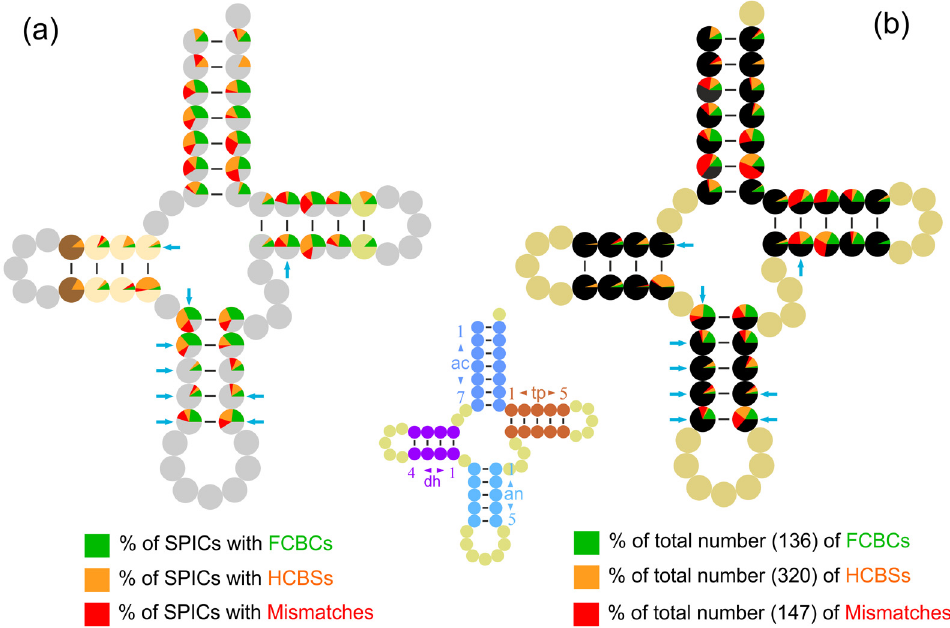
Fig 4. Global distribution of SPICs and CSBPSs in cetacean tRNAs. CSBPS, change in sequence in a base pair of a stem; FCBC, fully compensatory base change; HCBC, hemi compensatory base change; Mismatch, mismatch in a base pair of a stem; SPIC, stem position involved in base change. (a) Percent of SPICs in the whole set of tRNAs involved in CSBPSs. The extension of the slices determining the percent and type of FCBCs, HCBCs, and Mismatches was scaled assuming that the whole coverage of a Pie graph was reached only when the considered position resulted in an SPIC for the entire set of tRNAs. (b) Percent of CSBPSs occurring in a considered SPIC with respect to the total number of CSBPSs. The cyan arrows point to stem positions known to be interested in species of Mammalia by an editing activity in at least one